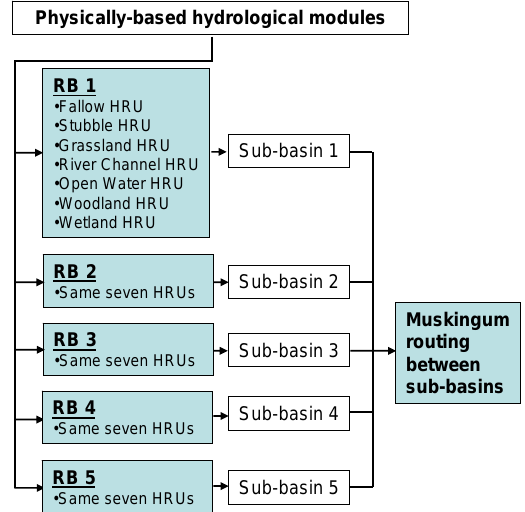
Fig. 4. CRHM modelling structure. Five Sub-basins are simulated by modelling structure “Representative Basin” (RB); same seven hydrological response units (HRUs) exist in each RB. Modelling structure of Muskingum routing connects all five